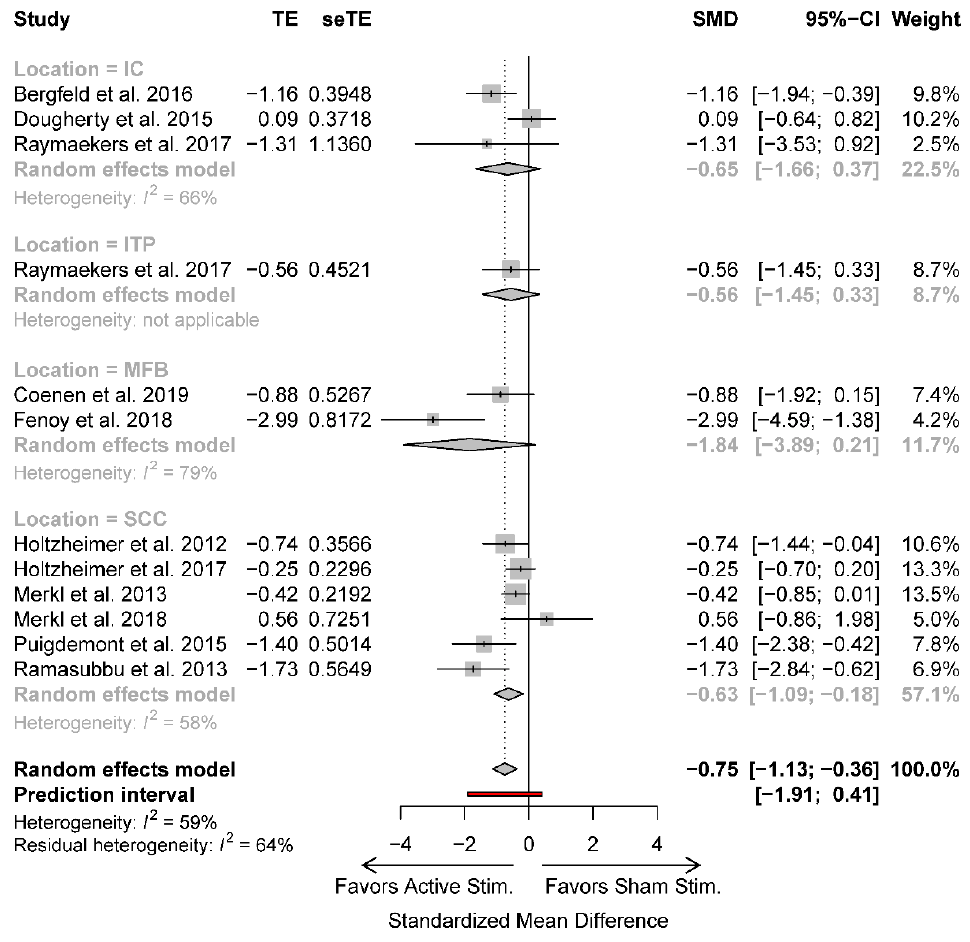
Figure 2. Meta-analysis forest plot depicting changes in HDRS/MADRS scores with active stimulation compared to sham stimulation. CI: confidence interval; IC: internal capsule; ITP: inferior thalamic peduncle; SMD: standardized mean difference; PI: prediction interval.